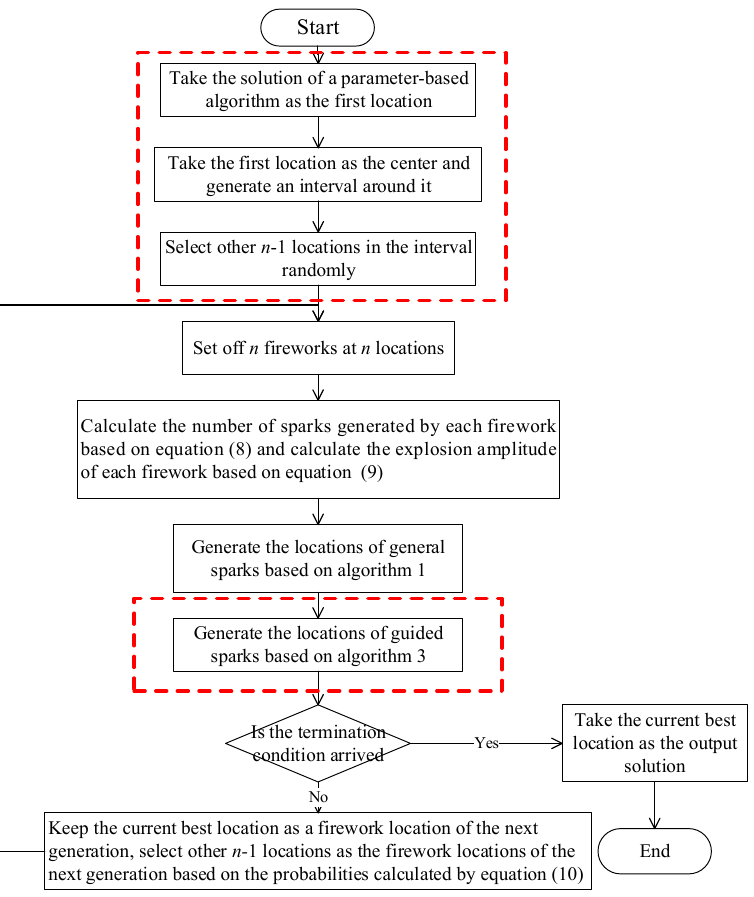
Figure 3. The flow chart of the Guided Fireworks Algorithm (GFWA).